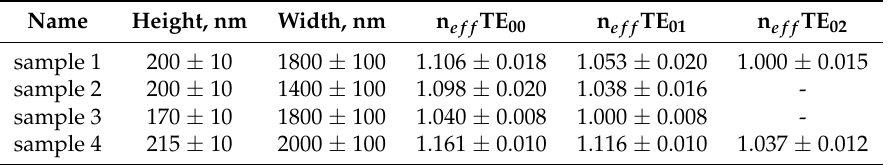
Table 1. Effective refractive index values obtained from experimental Back focal plane (BFP) images for different Bloch surface wave (BSW) modes propagating in the samples with different geometrical parameters of the